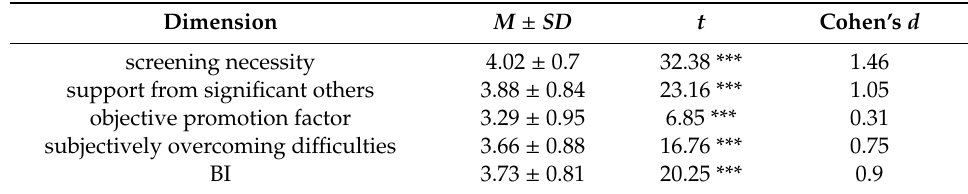
Table 3. TPB dimension scores ( n =